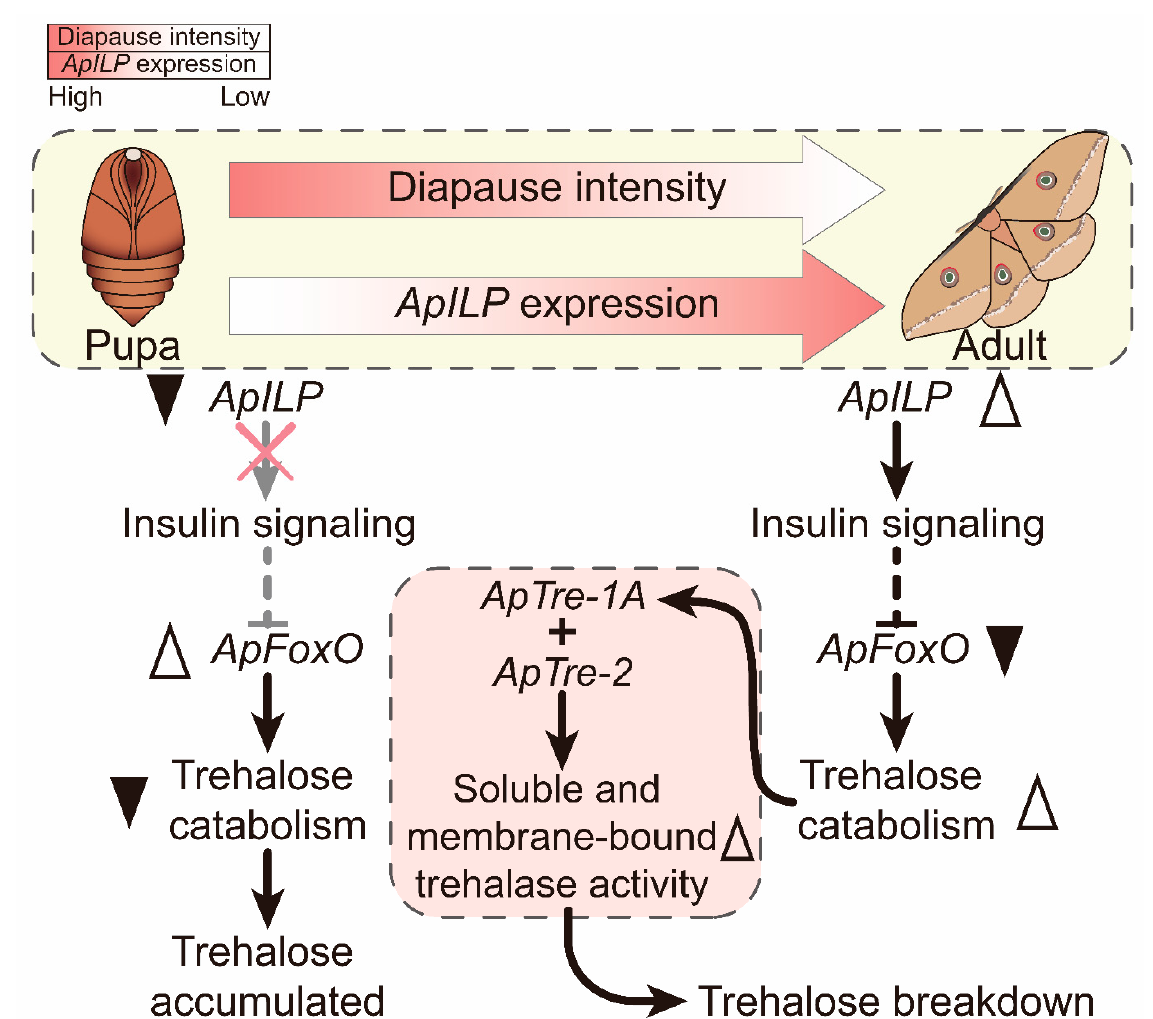
Figure 7. Schematic depiction showing that ApILP and ApFoxO are involved in the regulation of the trehalose catabolism in the diapause termination process in A. pernyi pupae. When A. pernyi pupae undergo diapause, the expression of ApILP is relatively low, and insulin signalling is repressed which, in turn, stimulates an increase in ApFoxO activity; then, ApFoxO reduces trehalase activity, thus suppressing trehalose hydrolysis. However, the expression of ApILP increases during diapause termination, which inhibits ApFoxO activity through the insulin/insulin-like growth factor signalling pathway. Subsequently, the increase in ApTre1A and ApTre2 expression triggers the activity of soluble and membrane-bound trehalase, which enhances trehalose catabolism and accelerates trehalose breakdown. Black indicates gene activation, while grey indicates